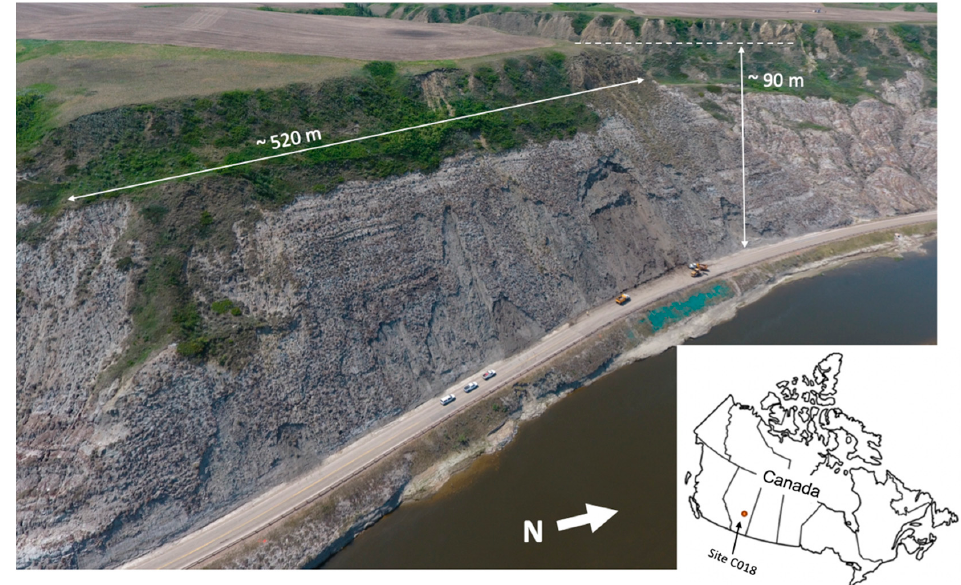
Figure 4. Location of the study site in Canada (lower right) and aerial view of Site C018.